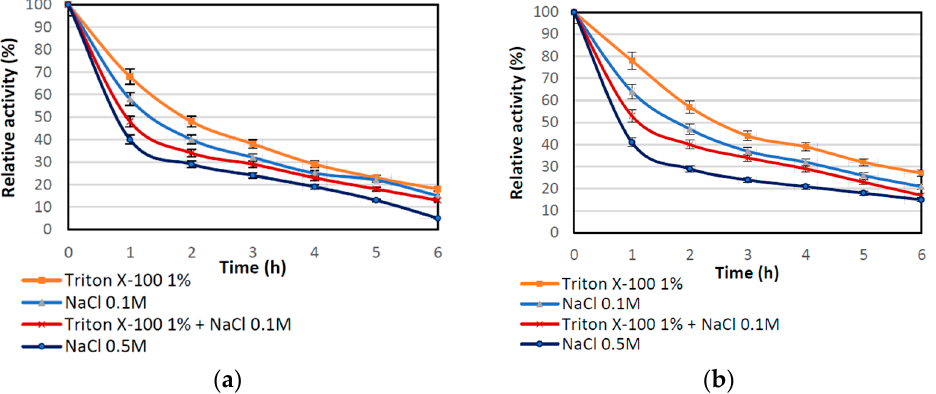
Figure 2. Effect of Triton X-100 and NaCl solution on the relative activity of immobilized enzyme: ( a ) by the adsorption interactions and partially interfacial activation ( b ) by mixed physical immobi- lization via interfacial activation and ion exchange. All experiments were performed in duplicate and the results presented in each of the graphs are shown as a mean value, for which standard deviation (error value) does not exceed 5%. Table 3. Amount of the immobilized lipase by two different methods remaining after desorption process, at different conditions, after 6 h. All experiments were performed in duplicate and the results presented in each of the graphs are shown as a mean value, for which standard deviation (error value) does not exceed 5%. Amount of Immobilized Enzyme (mg/g) Type of Eluent Nonmodified